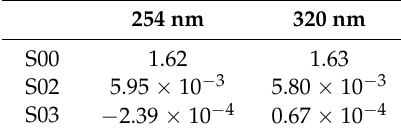
Table 1. Fitting results for various wavelength settings of the photoelastic modulator (PEM).